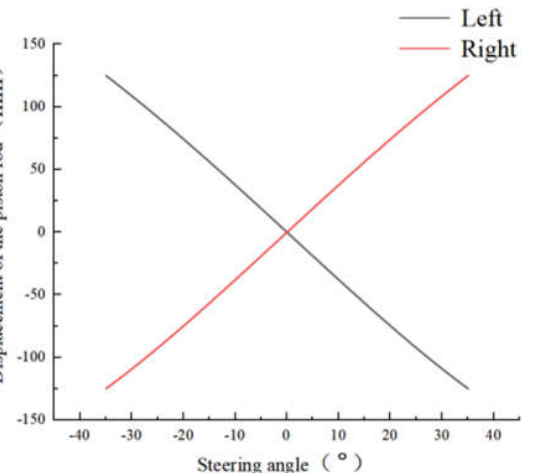
Figure 2. Simulation curve of the corresponding relationship between piston rod displacement and steering angle.